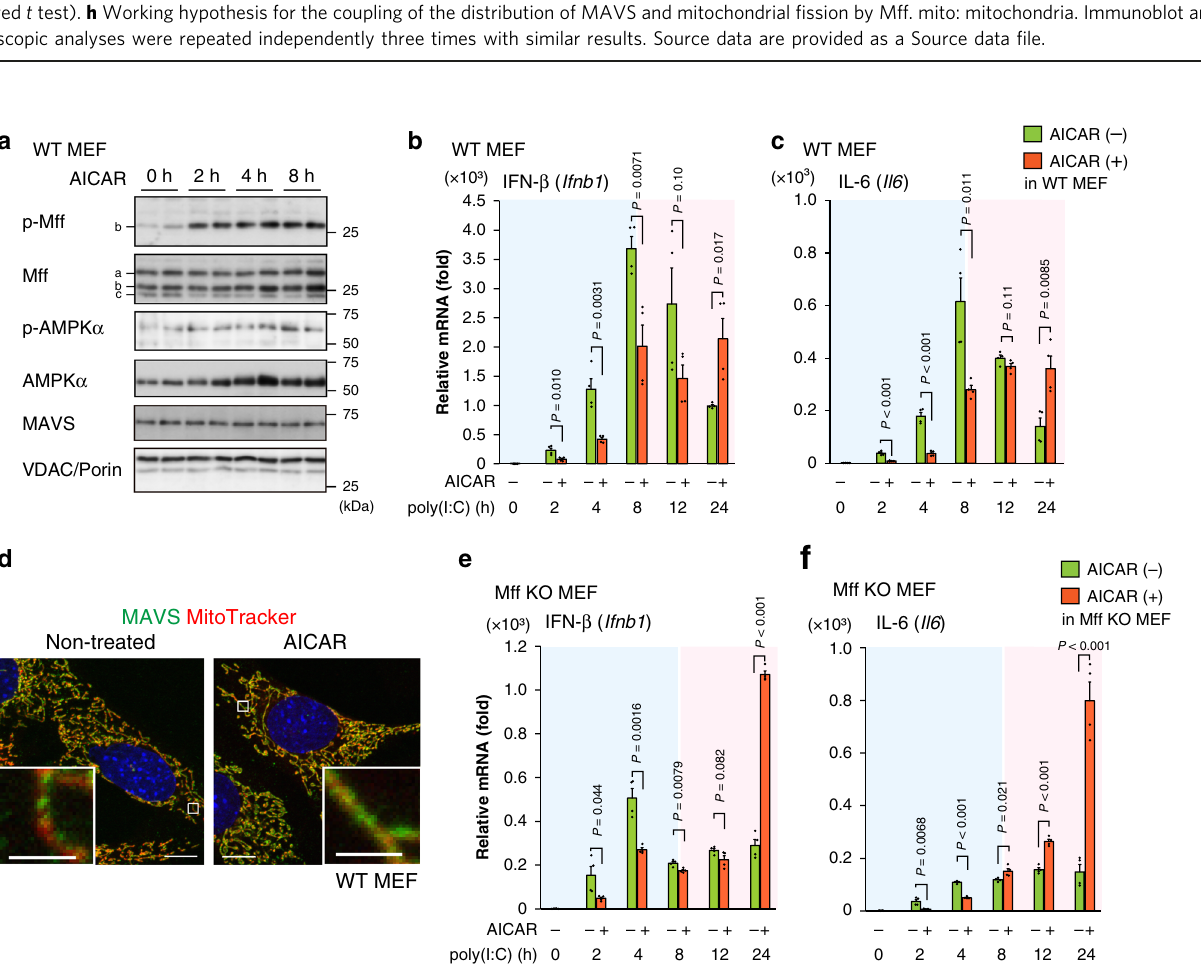
Fig. 4 The acute antiviral response is decreased in AICAR-treated cells with Mff phosphorylation. a WT MEFs were treated with the AMPK activator AICAR (2 mM) for the indicated times. Whole-cell lysates were analyzed by immunoblotting using antibodies against the indicated proteins. The indicated letters (a, b, c) correspond to the endogenous Mff bands observed in WT MEFs. b , c qRT-PCR analyses of IFN- β ( b ) and IL-6 ( c ) mRNA in WT MEFs transfected with poly(I:C)-LMW (1 μ g/mL) in the absence ( − ) or presence ( + ) of AICAR (2 mM, pretreated for 2 h) for the indicated times. d WT MEFs were stained with MitoTracker Deep Red (mitochondria; red) and then treated with or without AICAR (2 mM) for 8 h. After fi xation and permeabilization, cells were immunostained with an anti-MAVS antibody (green). Nuclei were stained with Hoechst 33342 (blue). Scale bars: 10 μ m (whole) and 2 μ m (inset). e , f qRT-PCR analyses of IFN- β ( e ) and IL-6 ( f ) mRNA in Mff KO MEFs transfected with poly(I:C)-LMW (1 μ g/mL) in the absence ( − ) or presence ( + ) of AICAR (2 mM, pretreated for 2 h) for the indicated times. The blue shaded parts of the graphs (0 – 8 h) represent the acute phase after poly(I:C), and the red shaded parts (8 – 24 h) represent the tolerant phase in b , c , e , f . Data represent means ± SEM from two independent experiments ( n = 4, P values; two-tailed unpaired t test) in b , c , e , f . Immunoblot analyses and all microscopic analyses were repeated independently more than three times with similar results. Source data are provided as a Source data fi